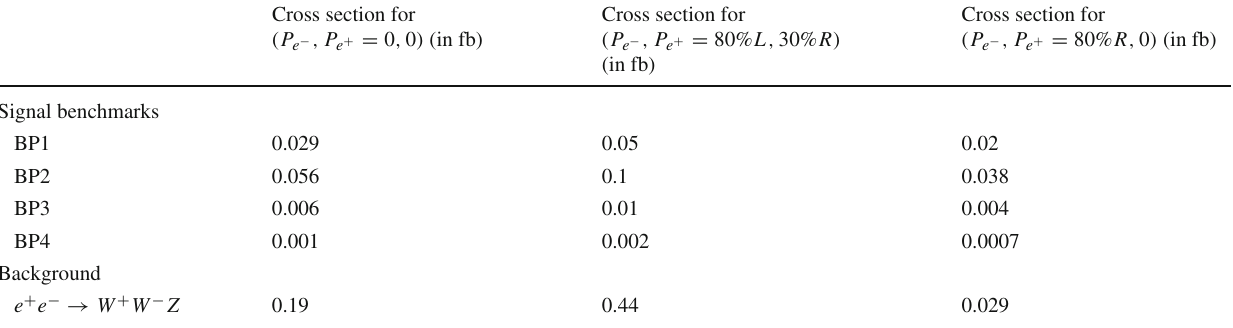
Table 13 The effective cross-sections of the signal and background for 4 (cid:10) + E / T signal at LO at 1 TeV ILC using unpolarised and polarised incoming beams Cross section for Cross section for ( P e − , P e + = 0 , 0 ) (in fb) ( P e − , P e + = 80% L , 30% R )